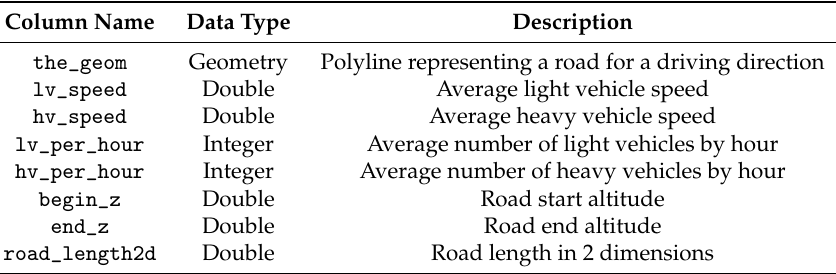
Table 6. Description of the road traffic input